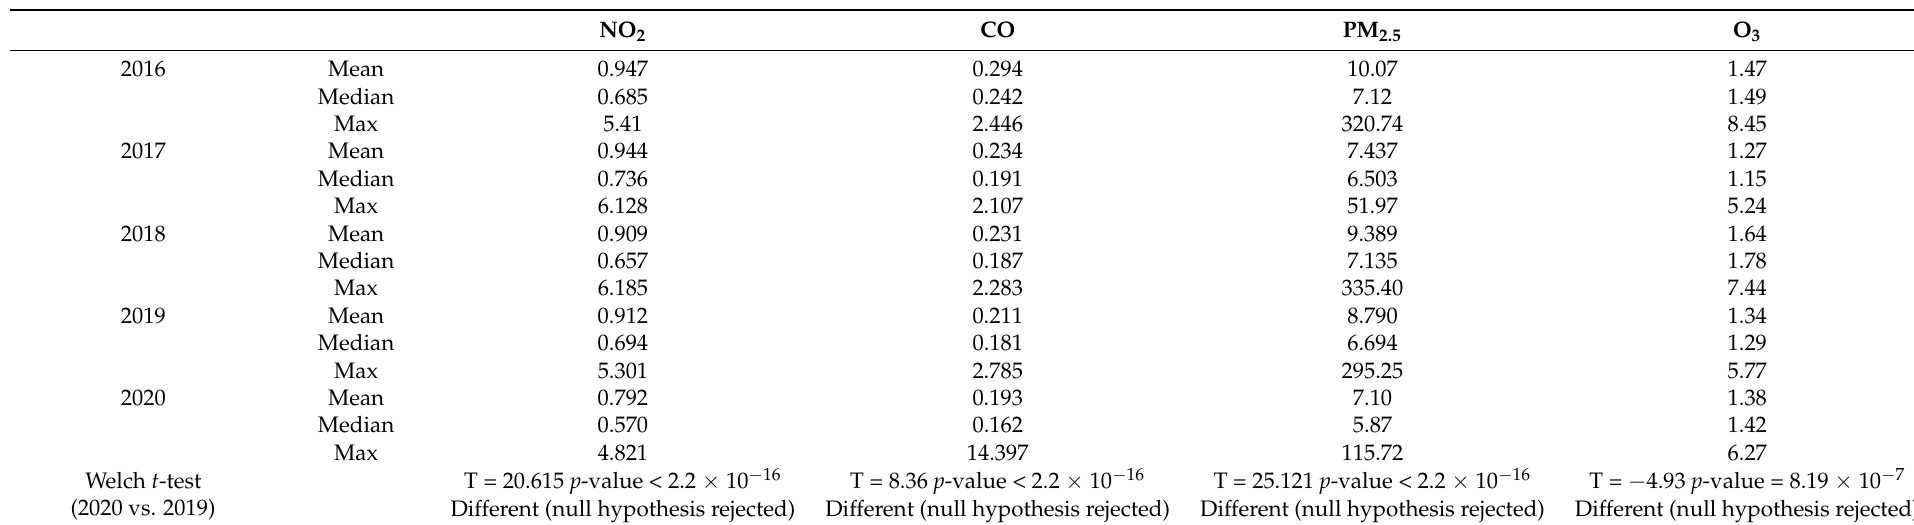
Table 3. Summary statistics of NO 2 , CO, PM 2.5 , and O 3 for the period from April to June in 2017, 2018, 2019, and